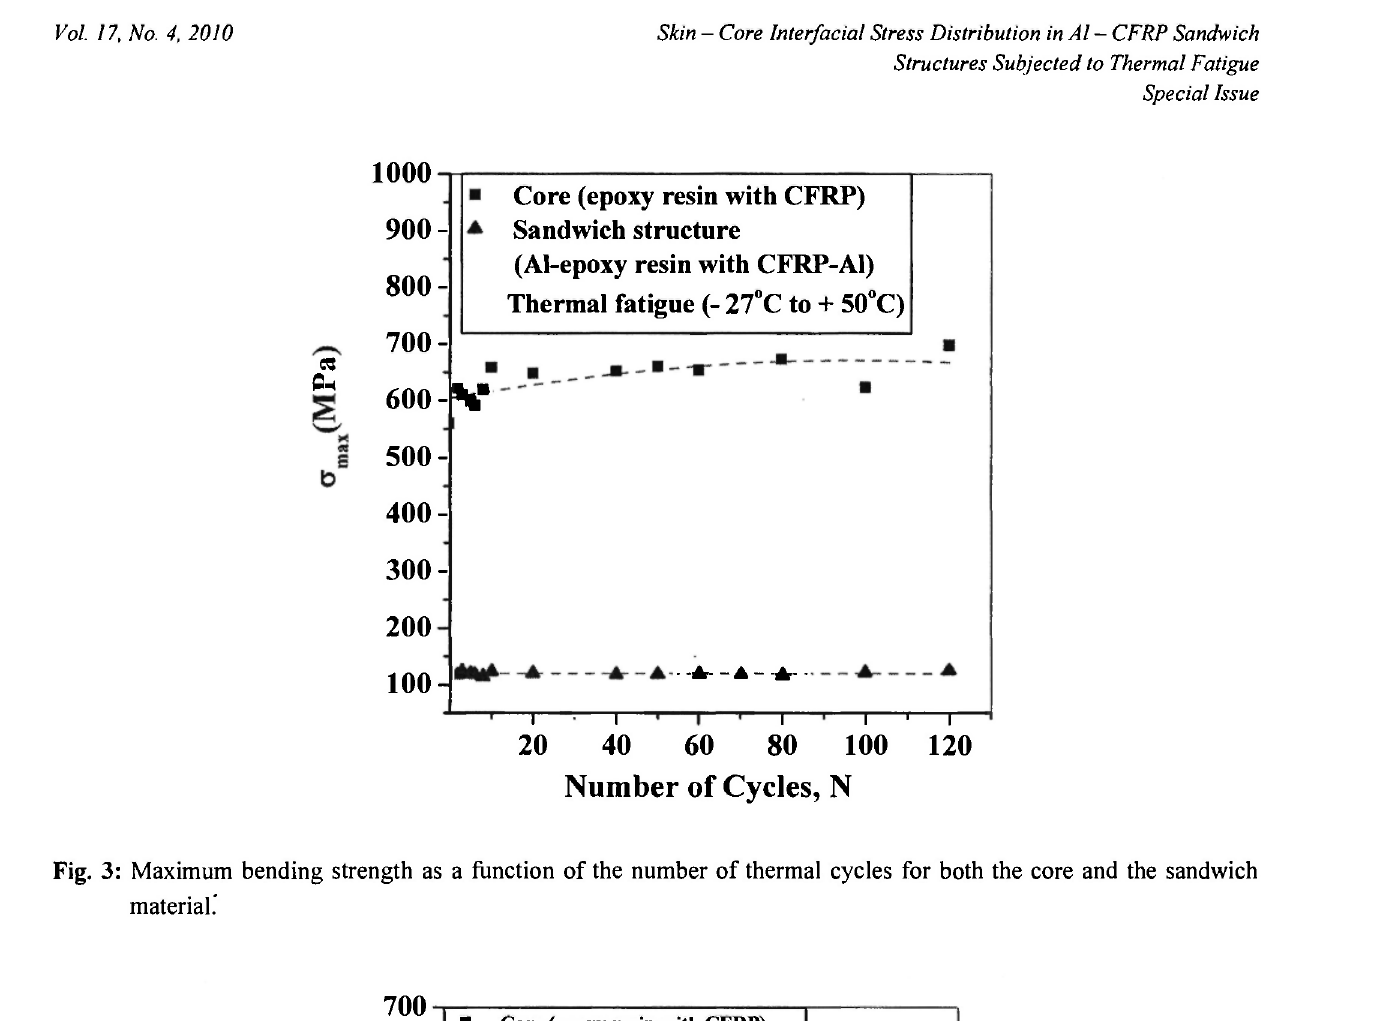
Fig. 3: Maximum bending strength as a function of the number of thermal cycles for both the core and the sandwich material.'